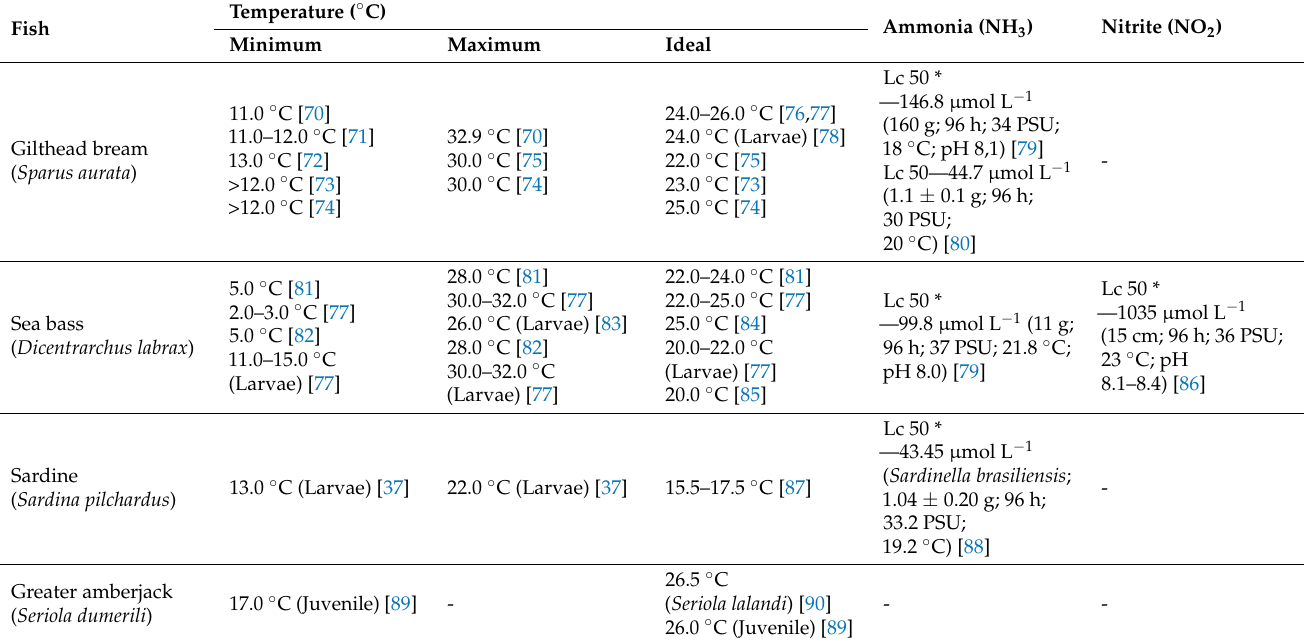
Table 4. Minimum, maximum, and optimal temperature ( ◦ C) and limits of ammonia ( µ mol L − 1 )